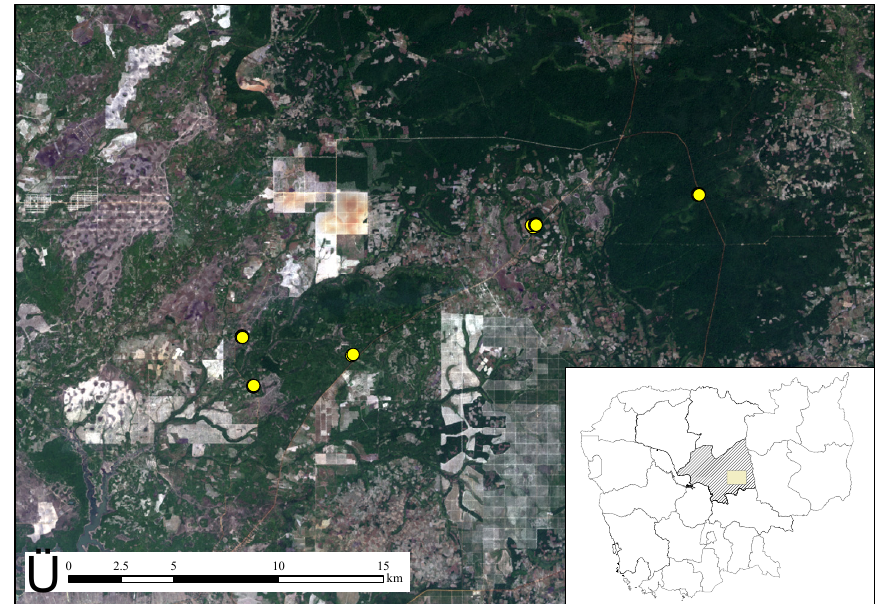
Figure 2. Location of permanent sample